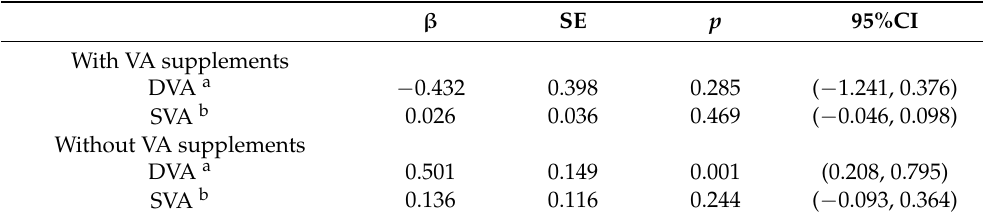
Table 3. Stratified analyses regarding the association of DVA with SVA. β SE p 95%CI With VA supplements DVA 0.034 ( − 0.660, 0.728) Without VA supplements DVA 0.174 (0.025, 0.324)